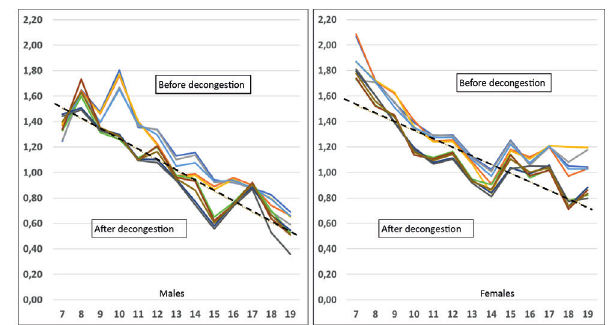
Figure 3. Age-dependent decrease in logarithmic vertex resistance and effective